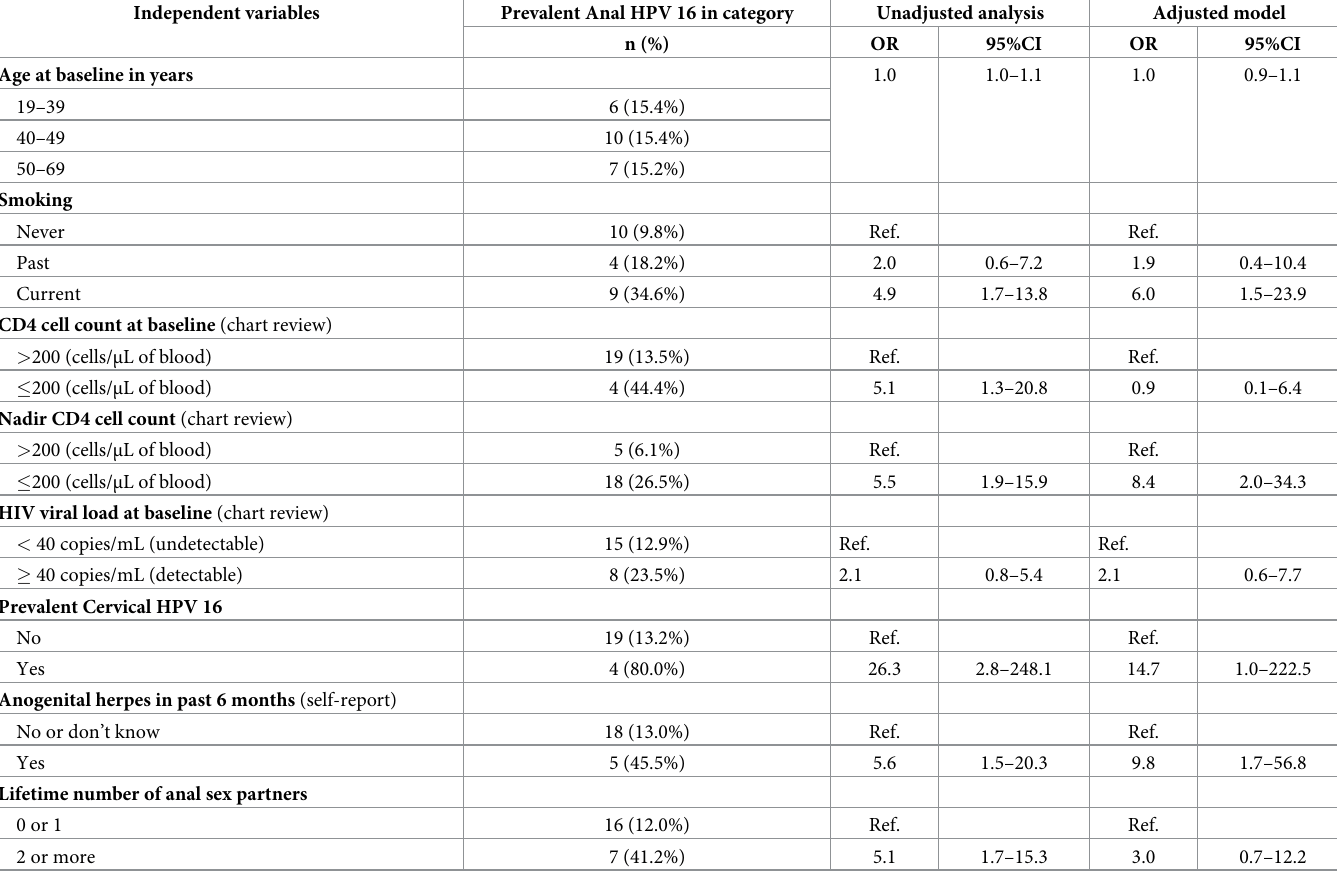
Table 2. Factors associated with prevalent anal HPV 16